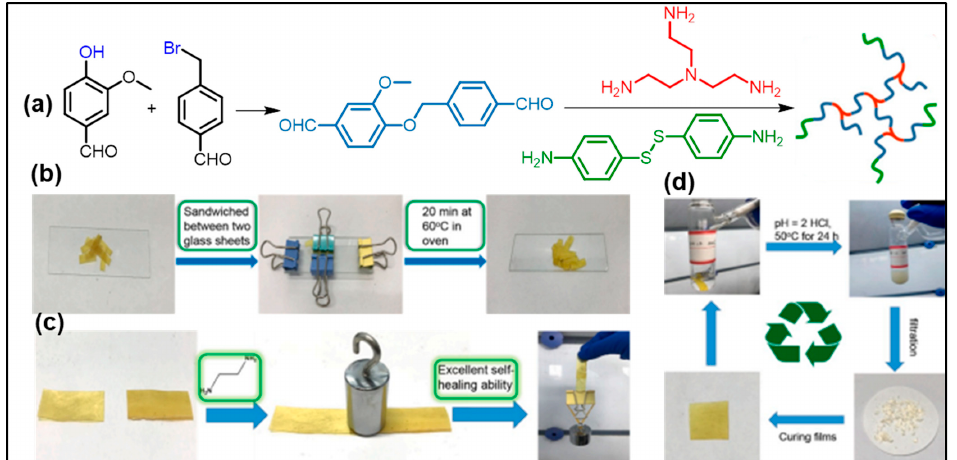
Figure 8. ( a ) Synthesis pathway of vanillin vitrimer; ( b ) mechanical regeneration of finely ground vitrimers; ( c ) self-healing performance of the cut samples that could sustain 500 g of load; and ( d ) chemical reprocessing of the cured vitrimers [reproduced with permission from Guo et al.; published by Elsevier, 2020] [69].